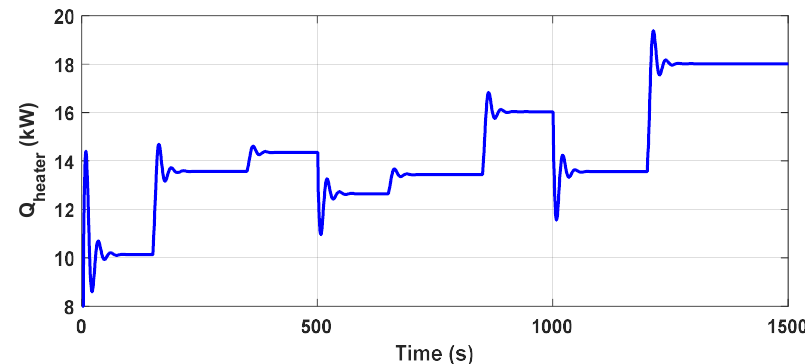
Figure 9. Corresponding control input.